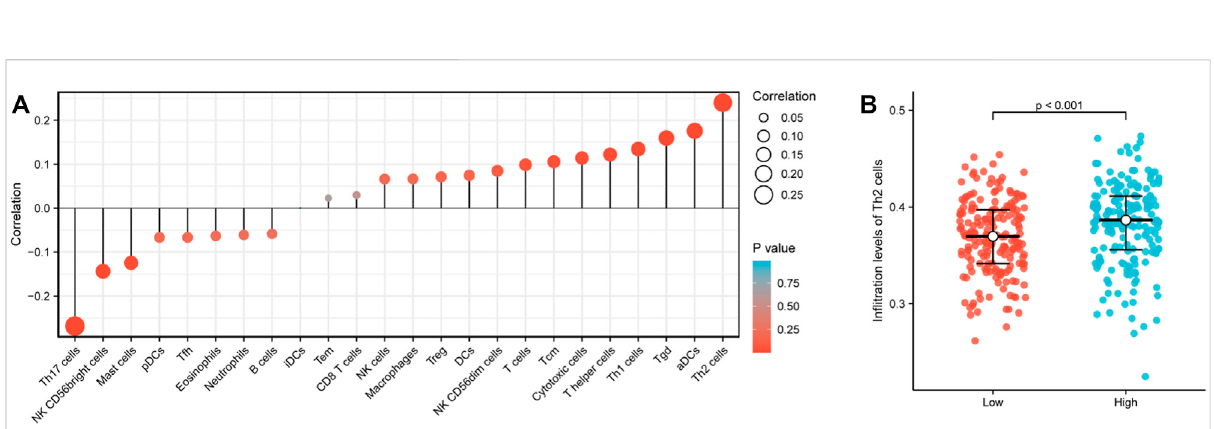
FIGURE 3 RPP30 expression level was associated with immune in fi ltration in the GC microenvironment. (A) Correlation between the marker gene of 24 immune cells and RPP30 expression level is shown in the lollipop chart. The size of the dots shows the absolute value of Spearman ’ s correlation coef fi cient(r). Largerdots indicate higher correlation coef fi cients. RPP30expressionwaspositively correlated withtheabundancesofimmunocytes (Th2 cells, activated dendritic cells, Th1 cells, and helper T cells) and negatively correlated with the presence of Th17 cells. (B) Difference between RPP30 high and RPP30 low groups in terms of Th2 cell in fi